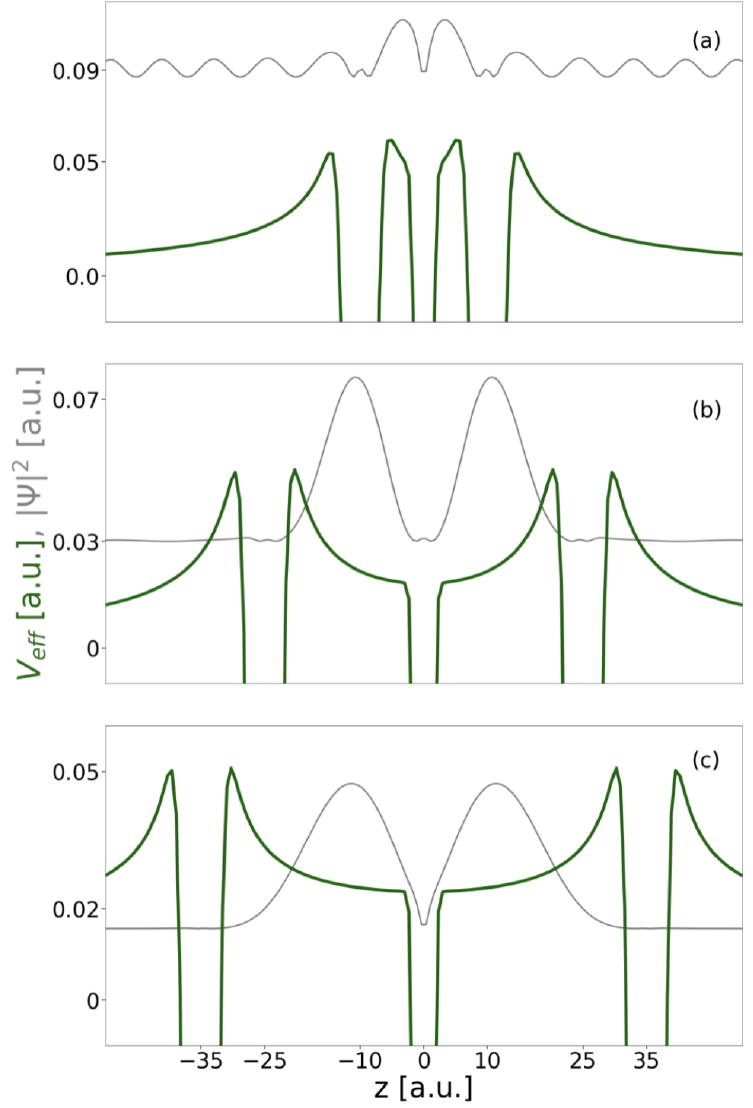
Figure 10. Illustration of the density | Ψ | 2 of the B ∗ single-electron state (thin, grey line) in the effective potential of the final DE electron configuration (thick, dark green line) for ( a ) R AB = 10a.u., ( b ) R AB = 25a.u., and ( c ) R AB =